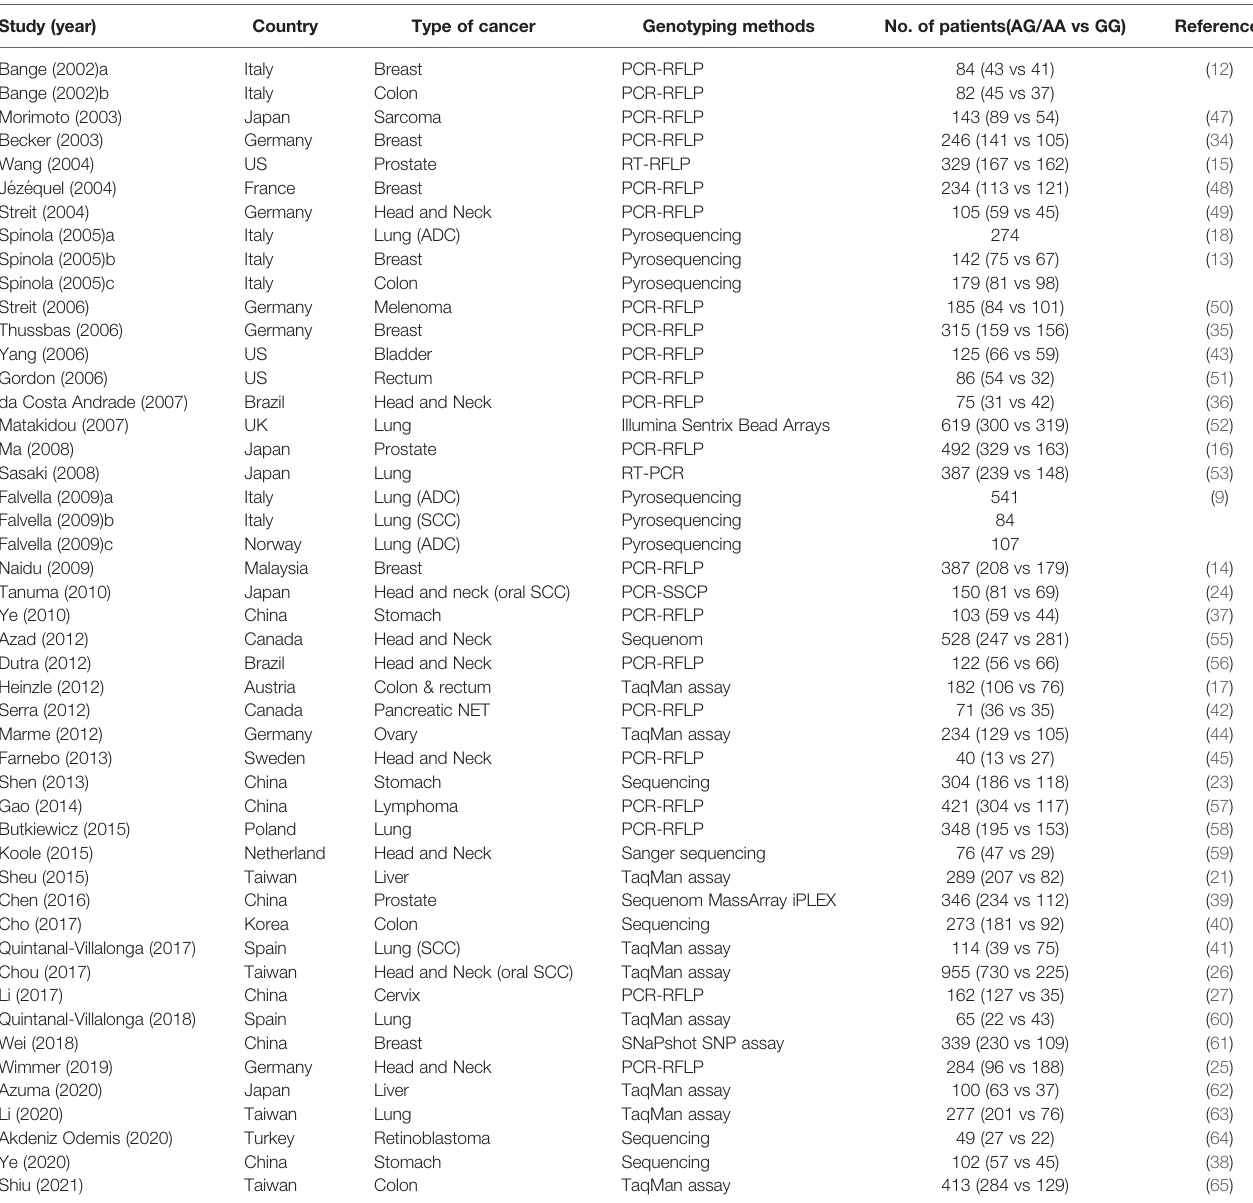
TABLE 1 | The summary of the 44 included